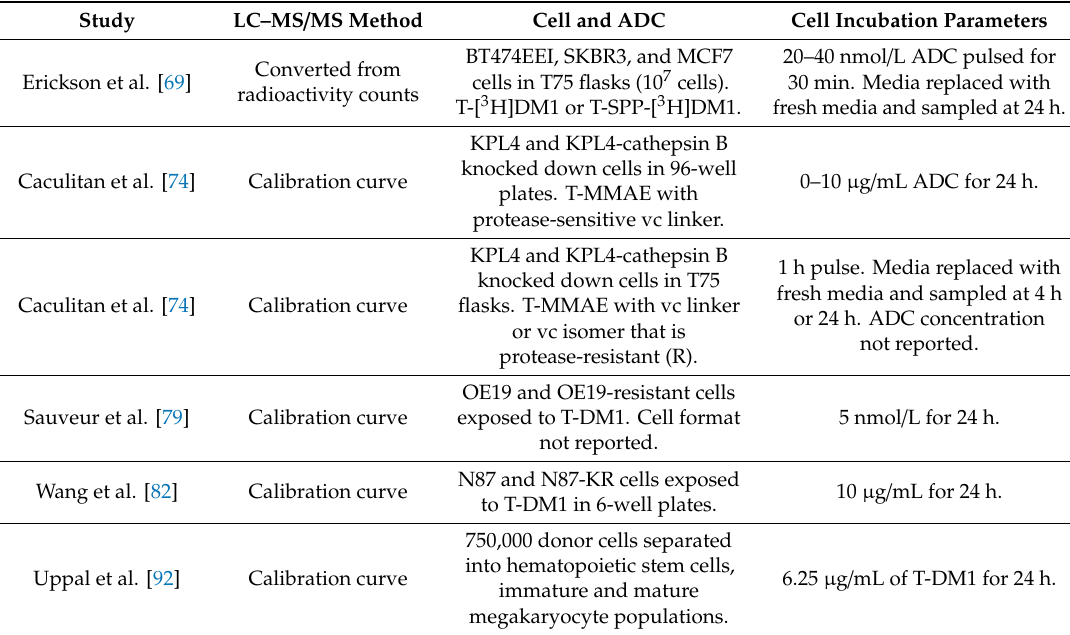
Table 2. Study designs for quantitative determination of ADC payload cellular